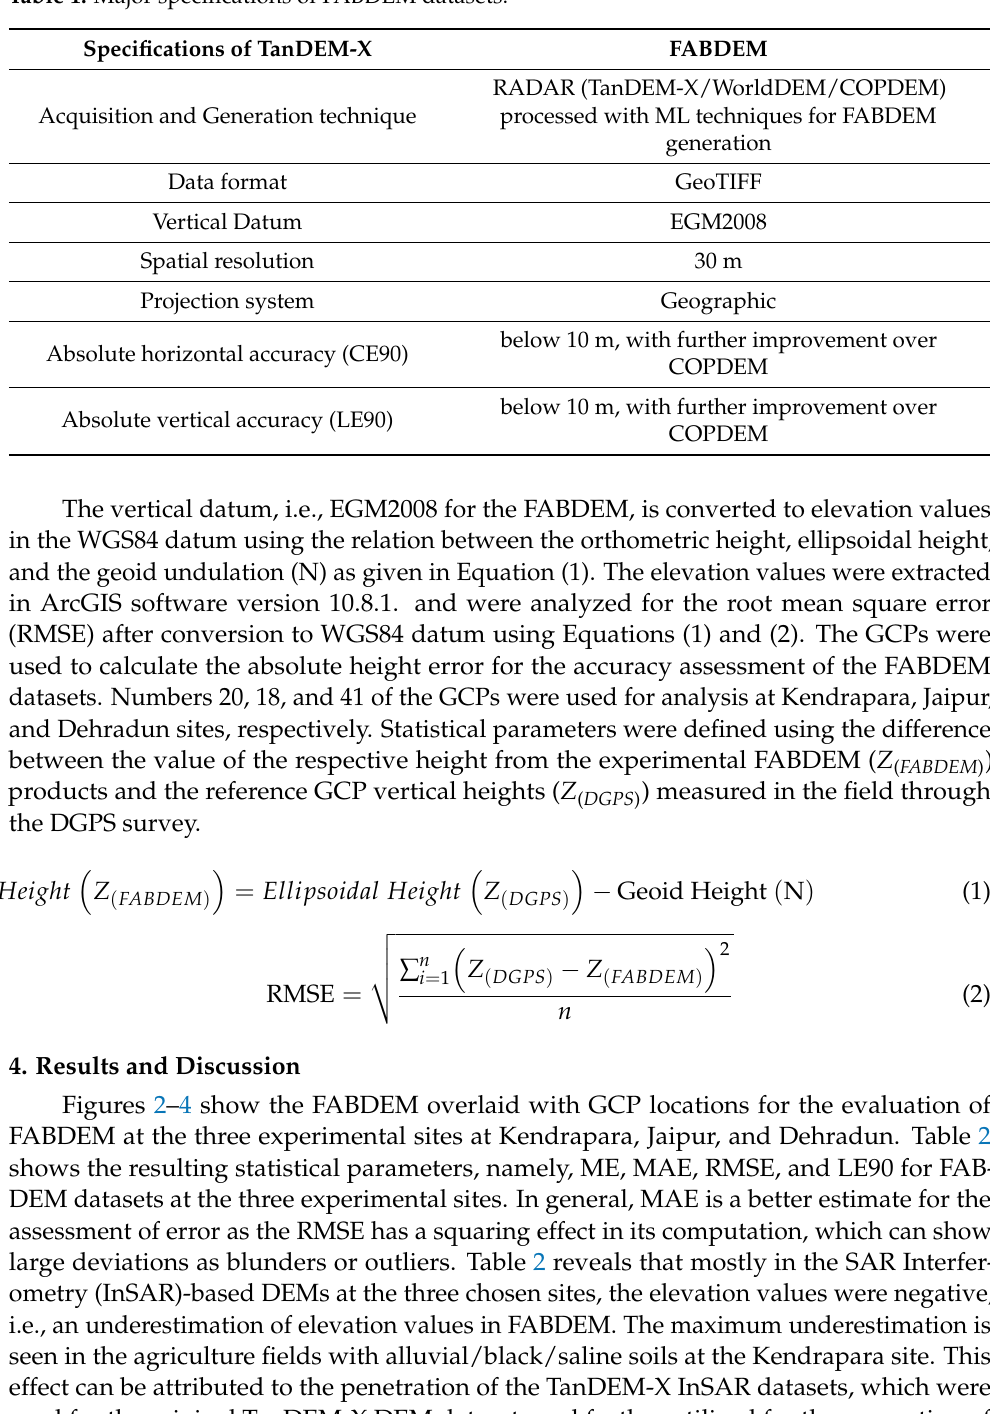
Table 1. Major specifications of FABDEM datasets.